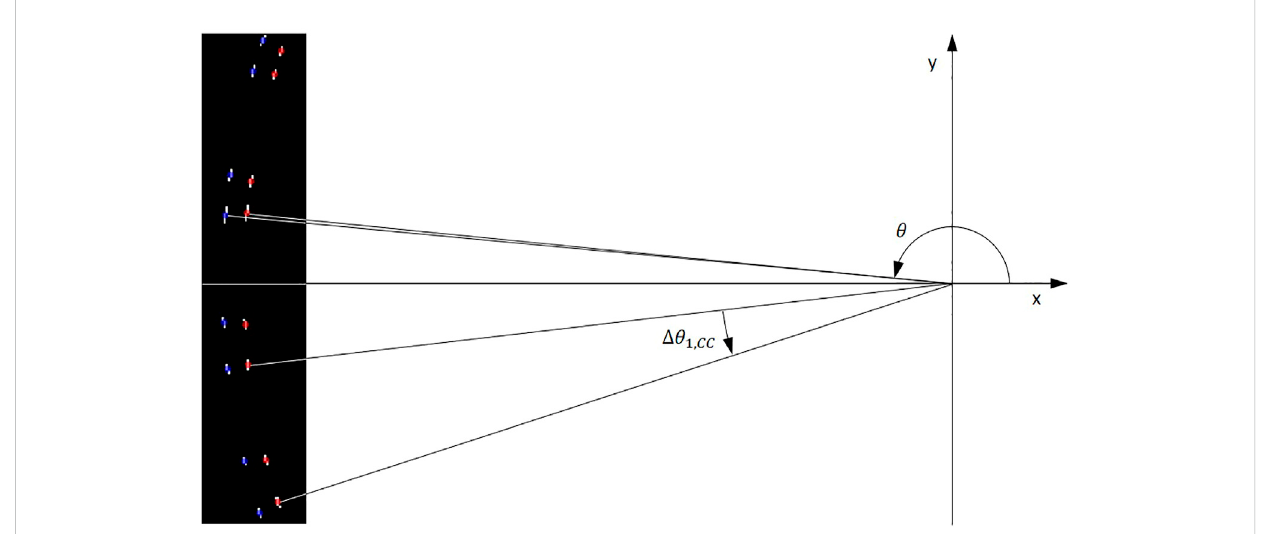
FIGURE 5 Close-up of white intersection objects resulting from the video frame in Figure 4; centroids of inner and outer intersection objects marked by red andbluedots,respectively;exemplarymeasurementofthepolarangle θ oftwointersectionobjectsthatoriginatefromthesameyarnforanidenti fi cation of the direction of yarn rotation; exemplary visualization of the angular yarn distance Δ θ 1 , CC between two neighboring yarns of counterclockwise (CC) direction of